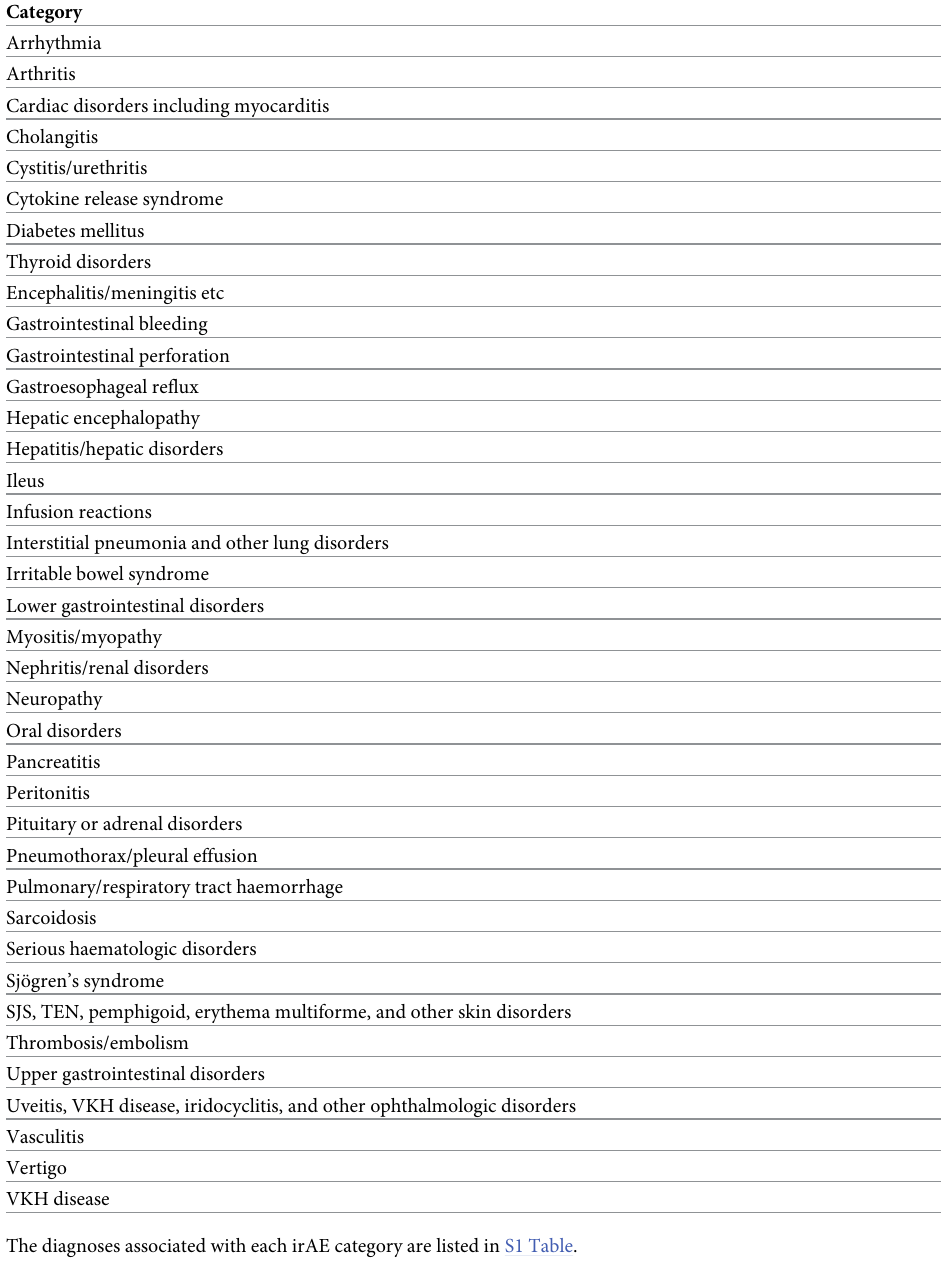
Table 1. Immune-related adverse events included in the online